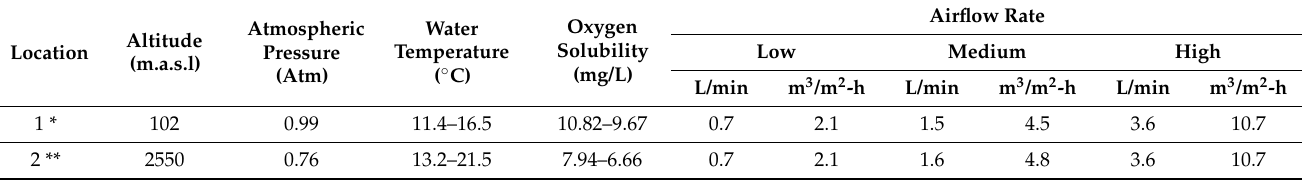
Table 1. Experimental characteristics for each